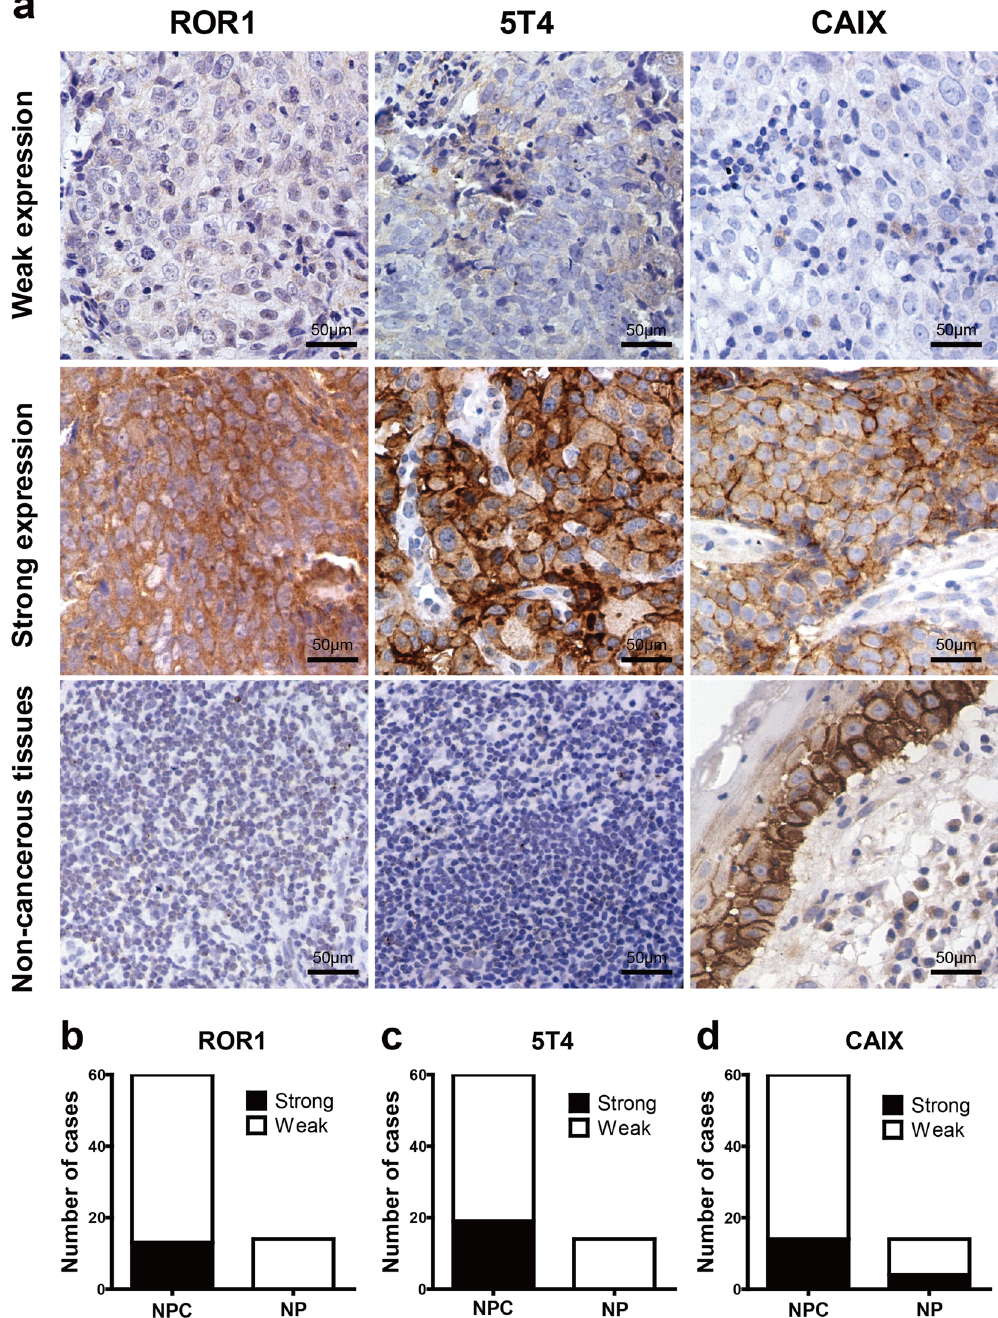
Figure 2. Expression of ROR1, 5T4 and CAIX in NPC tissues. ( a ) The expression patterns of ROR1, 5T4 and CAIX in NPC tissues were determined using IHC with the corresponding antibodies. Representative images of weak expression (score ≤ 4), strong expression (score ≥ 6) and the negative control for each gene are shown. A detailed description is provided in the Methods section. The number of NPC cases (n = 60) and non-cancerous tissues (n = 14) with strong or weak staining of ROR1 ( b ), 5T4 ( c ) and CAIX ( d ) are shown in each